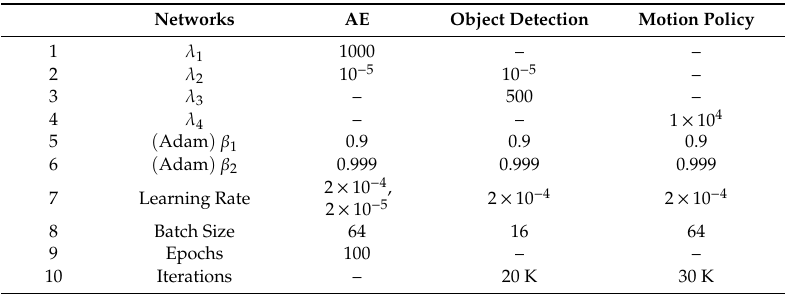
Table 1. Parameters of different network module in the training phase.